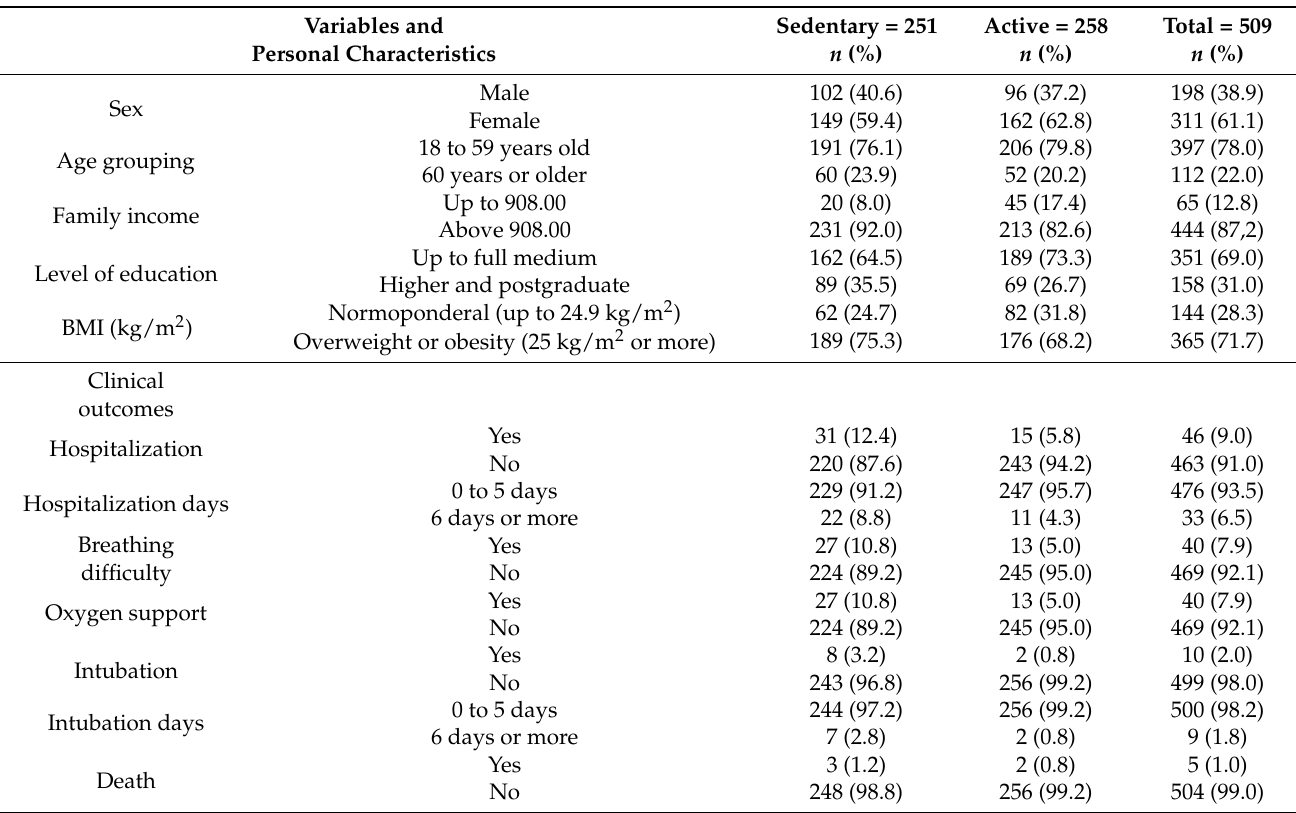
Table 1. Personal characteristics and clinical outcomes of the total sample, and grouped into sedentary and active. Ribeir ã o Preto, Brazil,